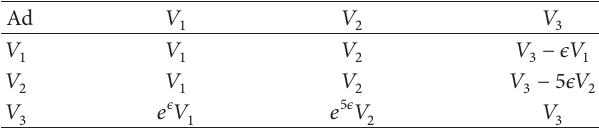
Table 8: Adjoint table of the Lie algebra of (3.3) . Ad 𝑉